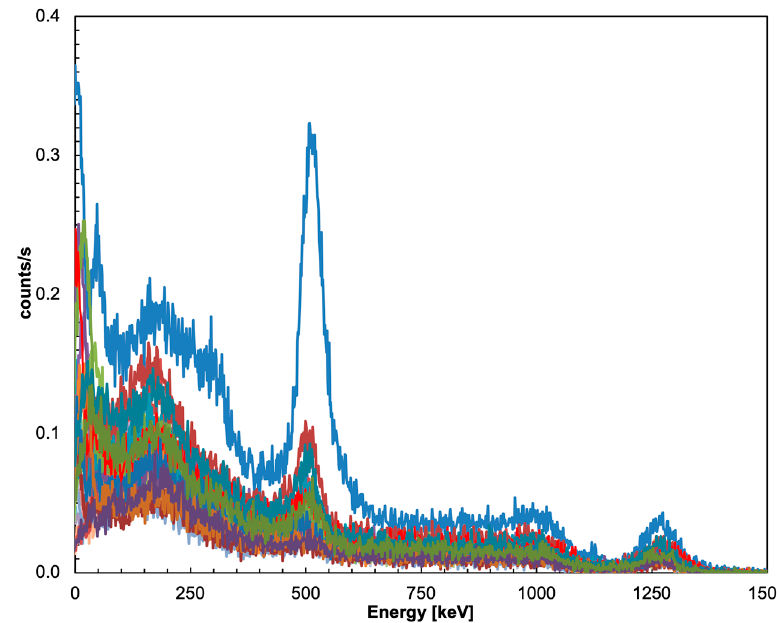
Figure 8. The 25 calibrated spectra from the configuration without the collimator.